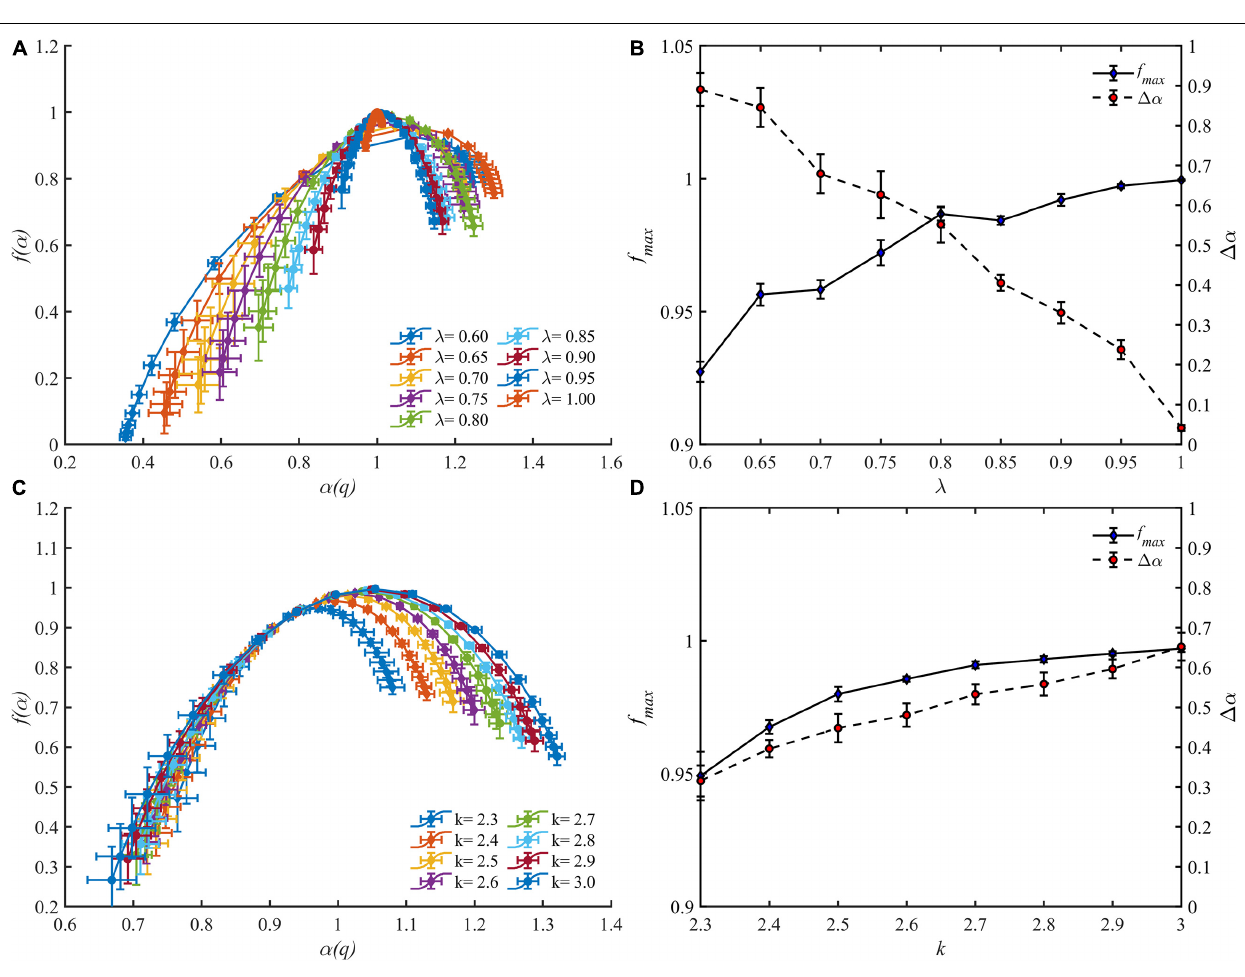
FIGURE 9 | The multifractal spectrums for blood flow of the vascular trees with varying λ (A) and k (C) . The range (cid:49) α and the maximal value f max of the multifractal spectrums with varying λ (B) and k (D) .